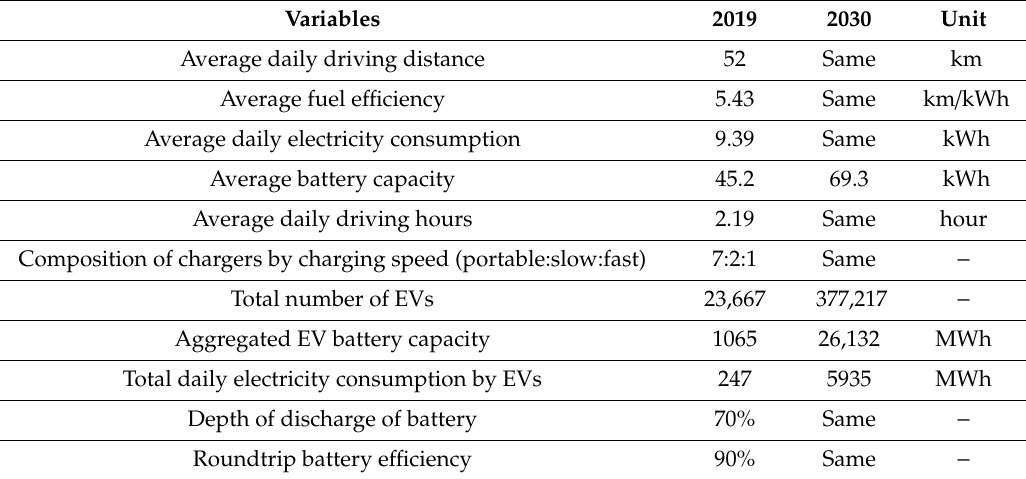
Table 3. EV characteristics in 2019 and 2030.